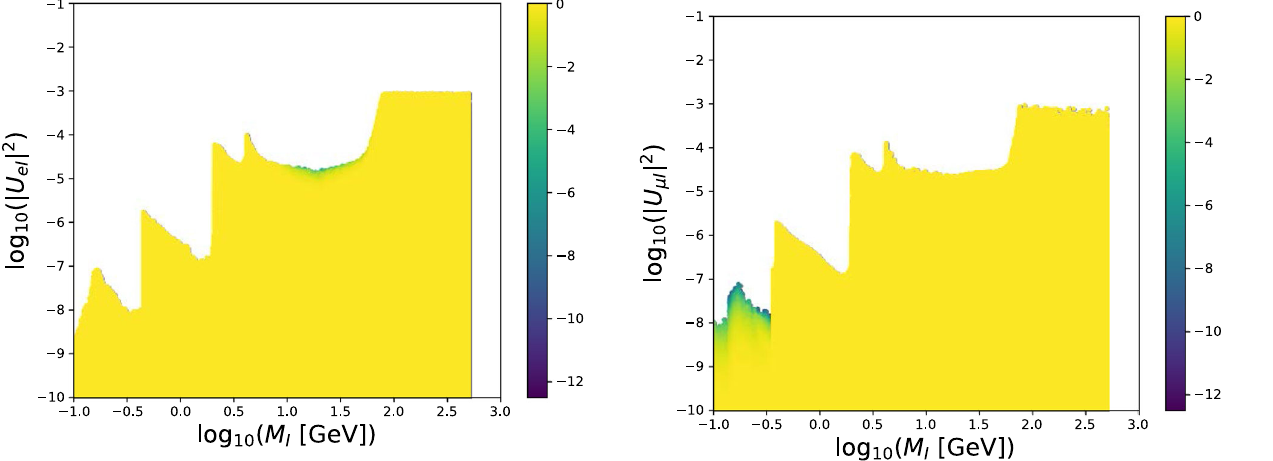
Fig. 26 PartiallikelihoodfromdirectsearcheswithPS191, μ -channel, in the M I − | U μ I | 2